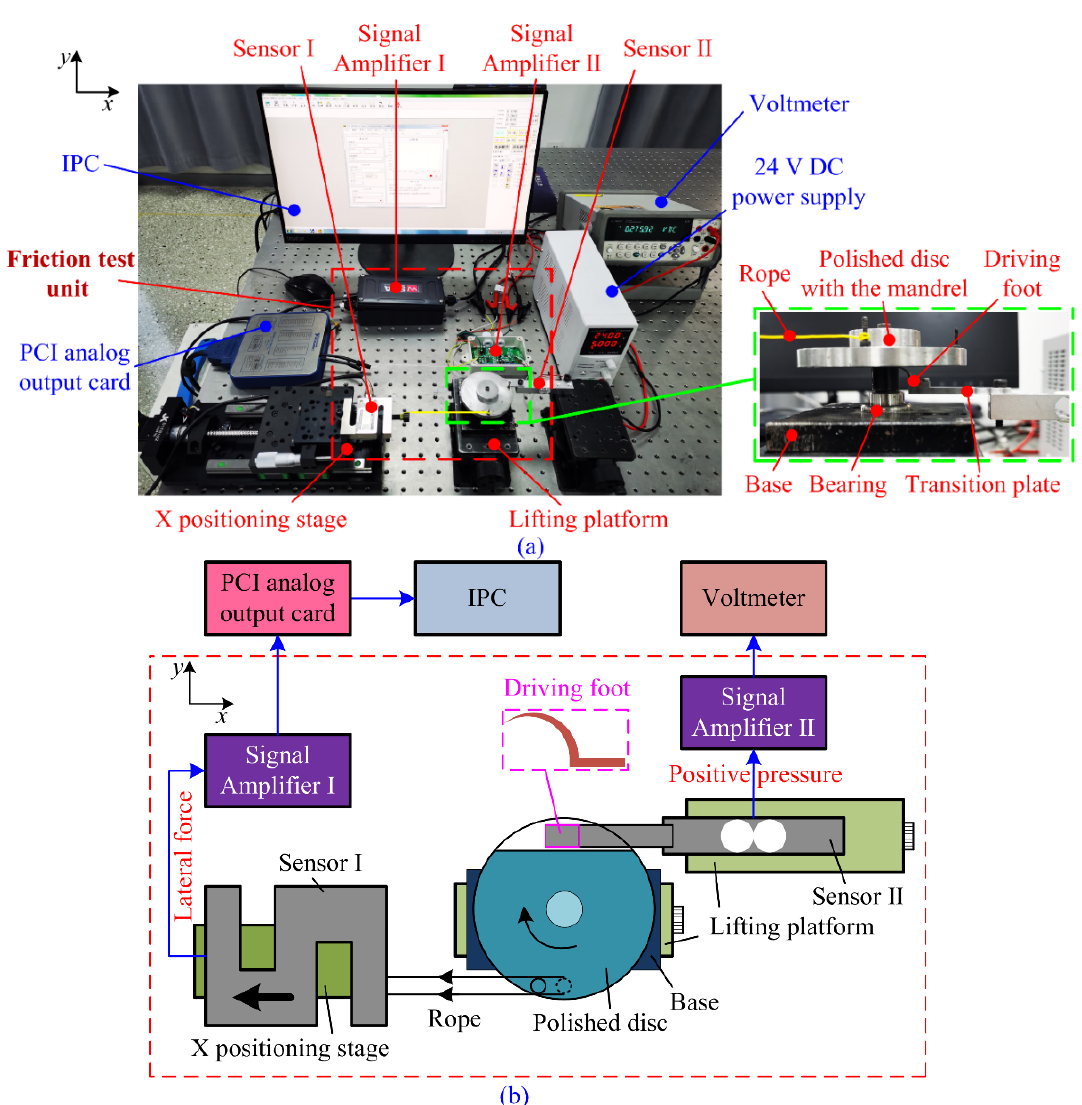
Figure 5. ( a ) The established experimental system for testing the friction properties of the four laser-textured driving feet and ( b ) a schematic diagram illustrating the measuring principle. Given the aforementioned experimental system and measuring principle, the maxi- mum static friction ( f o ) of the original driving foot was tested first, with a result of 0.47 N under positive pressure of 1.92 N, as shown in Figure 6. Then, the maximum static fric- tions ( f L ) of the four laser-textured driving feet were tested under the same positive pres- sure, with results of 0.57 N, 0.6 N, 0.57 N and 0.48 N, respectively, as shown in Figure 7. Accordingly, the friction coefficient ( μ o ) of the original driving foot is 0.24, and the friction coefficients ( μ L ) of the four laser-textured driving feet are 0.30, 0.31, 0.30 and 0.25, respec- tively. Compared with the original driving foot, the friction coefficients of the four laser- textured driving feet are increased. According to the asymmetric friction principles [38], if the difference in friction coefficient between the original end and the laser-textured end is larger, the actuator would have better output characteristics. Therefore, two kinds of microstructures (striped convex and square convex) were selected for subsequent experi- ments, named T a and T b microstructures, respectively, for convenience. To test the output characteristics of the actuator with these two microstructures, T a and T b microstructures were fabricated on the surfaces of the driving feet at one end by laser texturing.